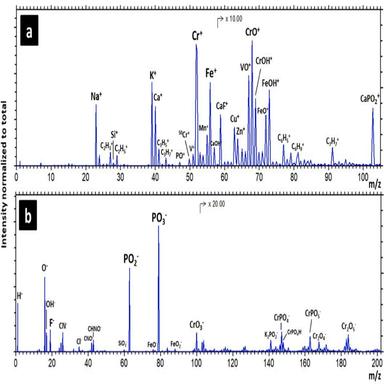
ToF-SIMS positive ion mass spectrum (a), negative ion mass spectra (b).